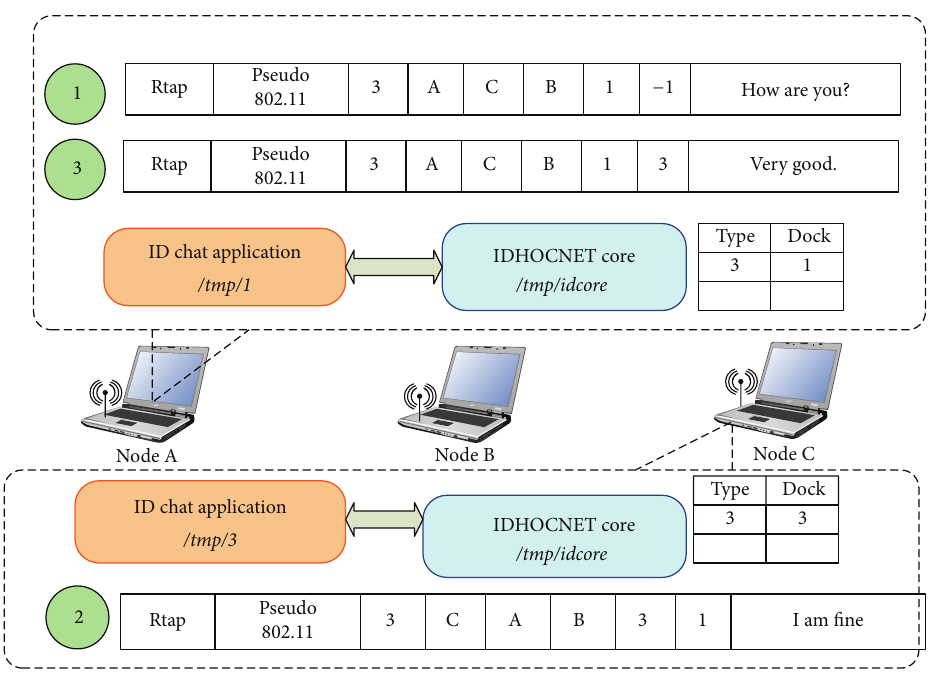
Figure 18: ID application process flow.